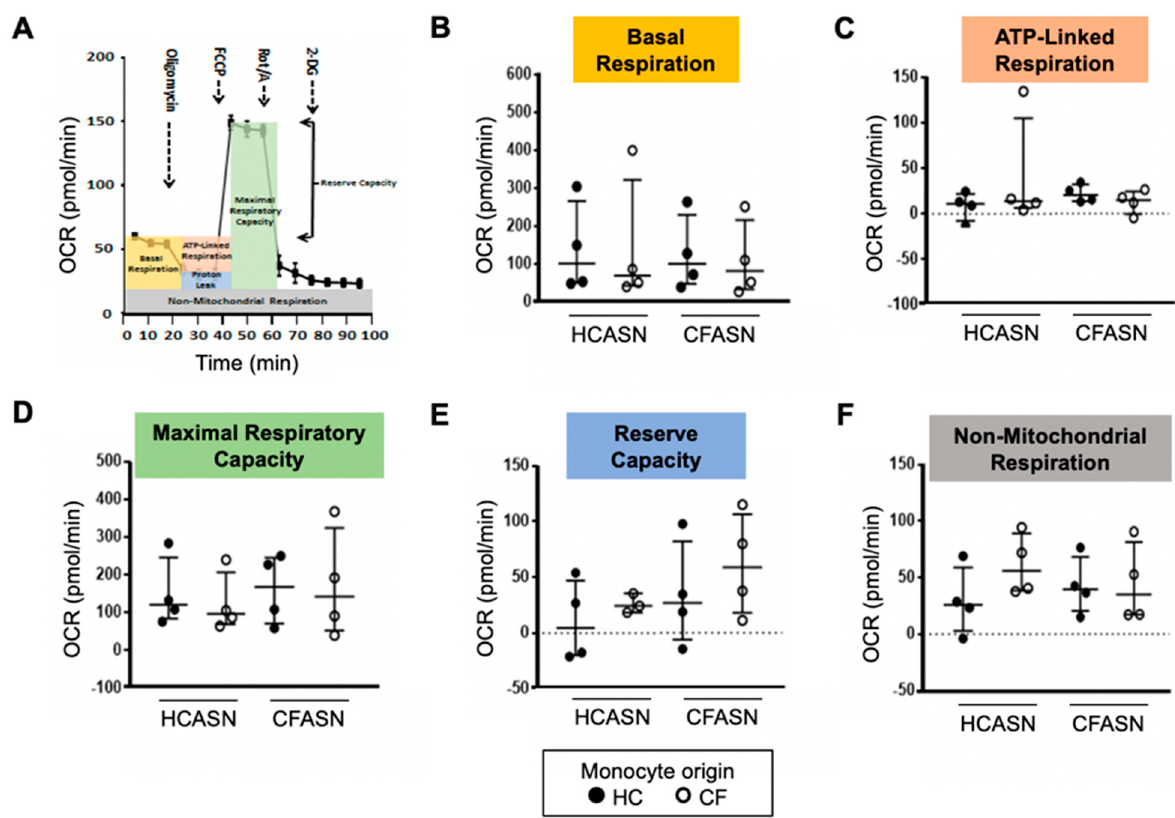
Figure 2. Metabolic activity of transmigrated monocytes. ( A ) Oxygen consumption rate (OCR) tracing upon sequential addition of oligomycin; fluoro-carbonyl cyanide phenylhydrazone (FCCP); rotenone and antimycin A (Rot/A); and 2-deoxyglucose (2-DG). OCR is used to compare ( B ) basal respiration, ( C ) ATP-linked respiration, ( D ) maximal respiratory capacity, ( E ) reserve capacity, and ( F ) non-mitochondrial respiration across types of transmigrated monocytes. Statistics: Mann-Whitney test for different monocytes (HC vs. CF) recruited to the same ASN; Wilcoxon signed rank test for the same monocytes recruited to different ASN (HC vs. CF). n = 4 per condition. Non-significant differences not shown.